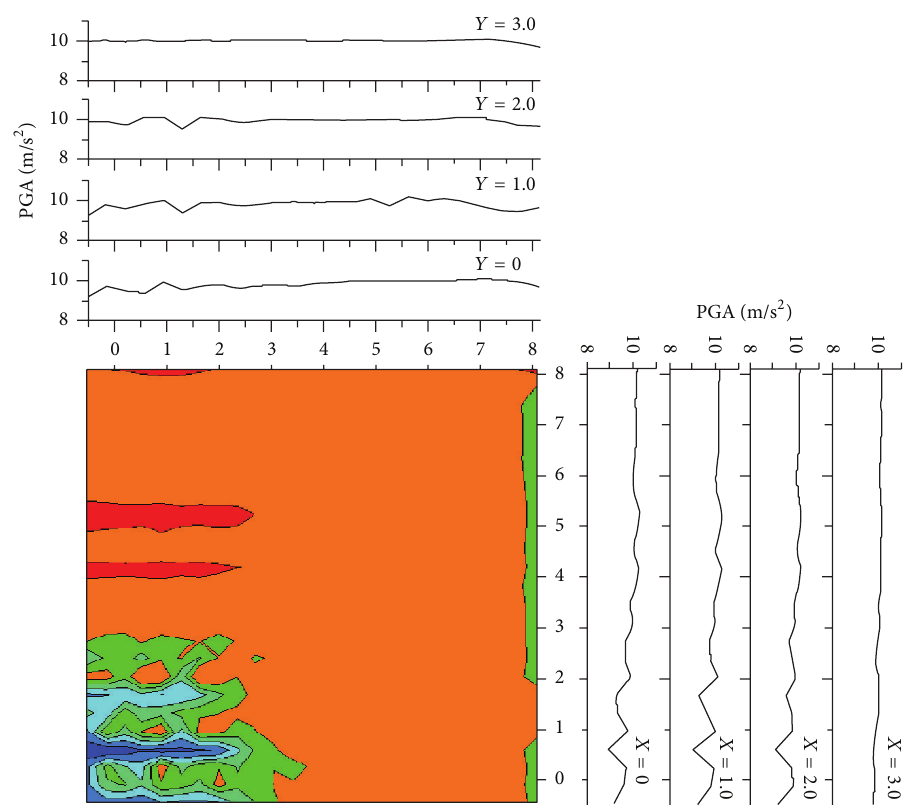
Figure 33: Peak ground acceleration distribution of URBAN6-6 with respect to nondimensional spatial coordinates (1/4 FE model, 𝐷 = 1.25 , V = 2 V 𝑆𝑋 . The structure location is (0, 0) , (0,1) , (0,2) , (1, 0) , (1,1) , (1,2) , (2, 0) , (2,1) , and (2, 2) ). The urban nondimensional 𝑠 𝑠 , El Centro, width is 6.0, the nondimensional effective width of a structural group parallel to the excitation is 8.0, and the nondimensional effective width of a structural group perpendicular to the excitation is